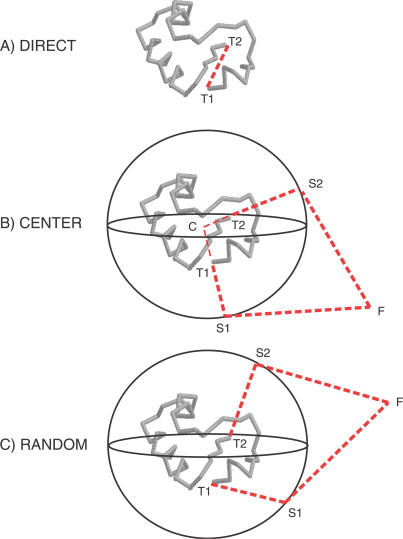
Illustration of the Three Chain Closure MethodsThe examples in these figures use the protein chain with PDB ID 1ejgA, rendered using Rasmol (R. Sayle).(A) DIRECT method. T
1 and T
2 refer to the terminals of the chain. We connect the terminals by the straight segment T
1 – T
2.(B) CENTER method. We enclose the entire chain in a sphere centered at C, the center of mass of the chain. We take straight lines starting at C, passing through the terminals T
1 and T
2, and intersecting the surface of the enclosing sphere at the points S
1 and S
2. S
1 and S
2 are connected to point F, located sufficiently far away outside the sphere, on the plane formed by C, S
1, and S
2. The closed loop is formed by the protein chain backbone complemented by the broken line T
1 − S
1 − F − S
2 − T
2.(C) RANDOM method. The points S
1 and S
2 are randomly positioned on the surface of the enclosing sphere whose center coincides with the center of mass of the chain. S
1 and S
2 are connected to point F, located sufficiently far away outside the sphere, on the plane formed by the center of mass, S
1 and S
2. A closed loop is again formed by the protein chain backbone complemented by the broken line T
1 − S
1 − F − S
2 − T
2.